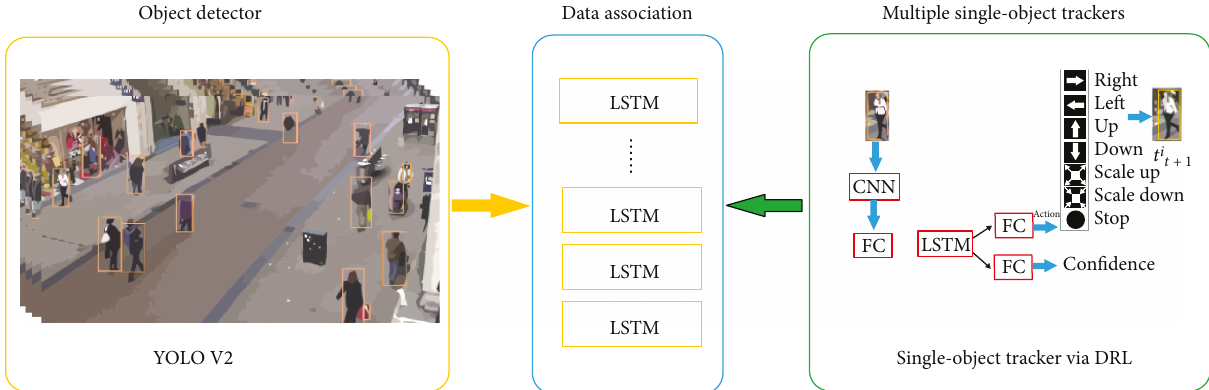
Figure 4: Overview of our proposed multiobject tracking